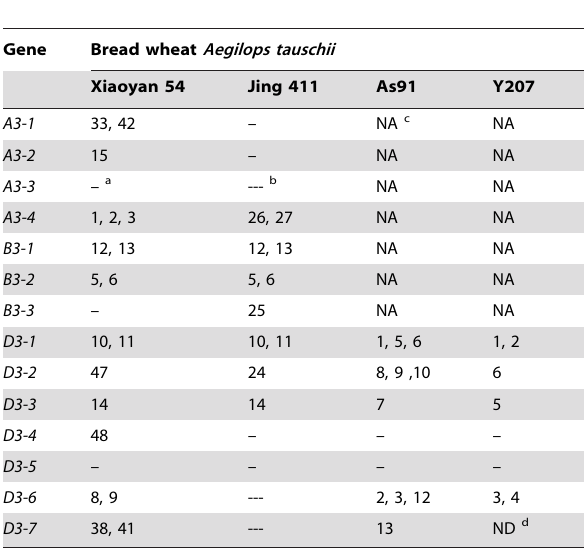
Table 2. Matching LMW-GS genes to the protein spots resolved by 2-DE through mass spectrometry